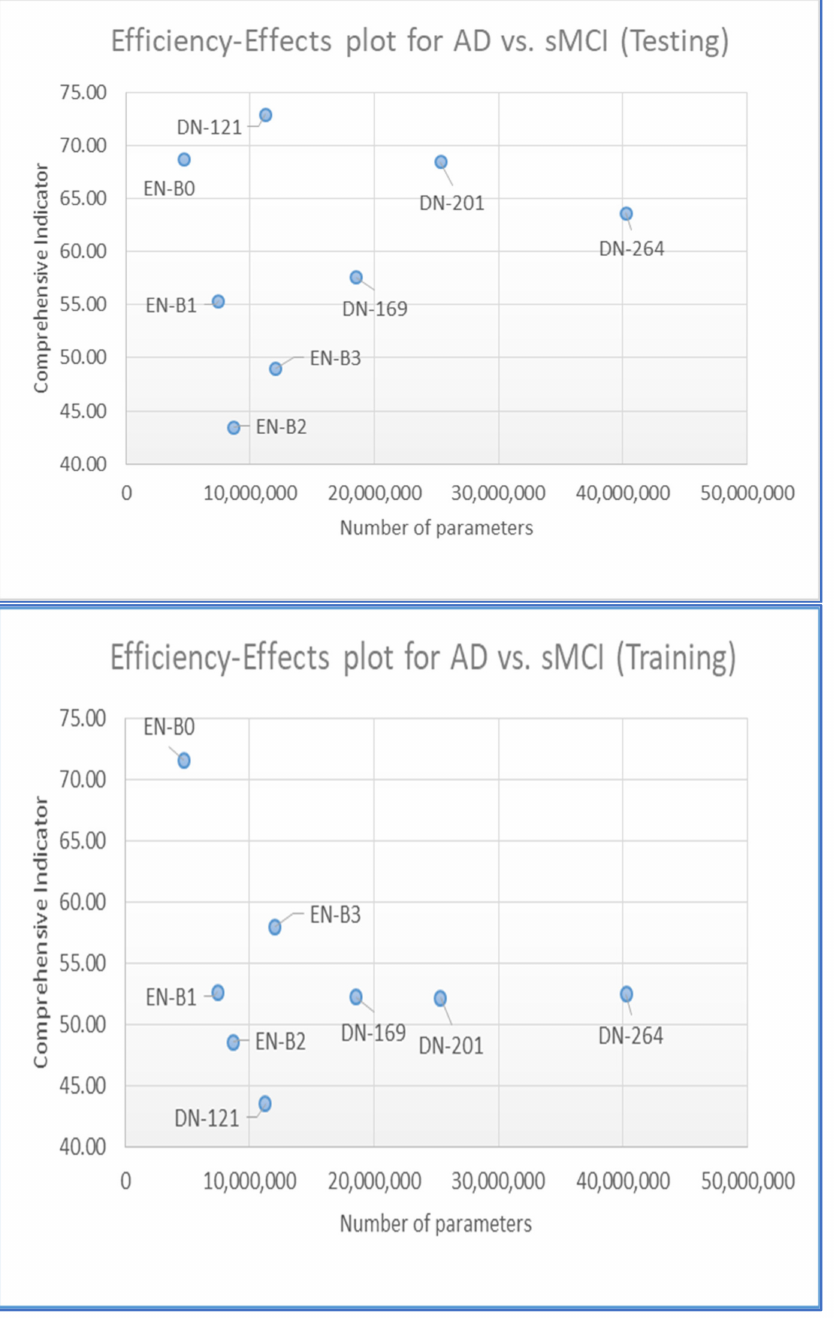
Figure 8. A comparison of the comprehensive performance indicators of eight deployed models for AD vs. sMCI